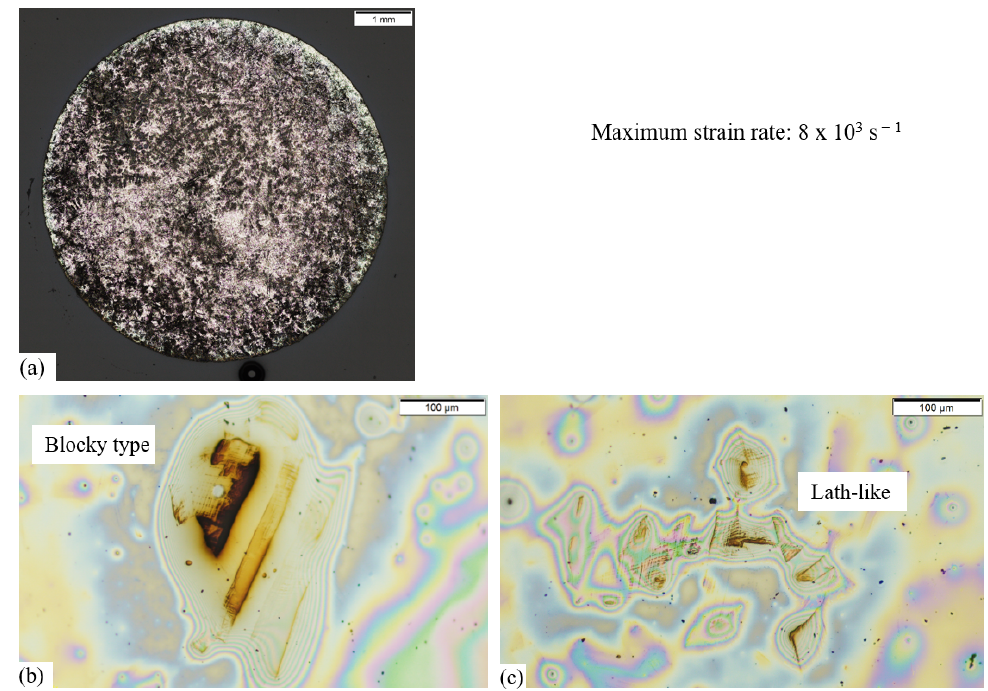
Figure 9. Microstructure analysis of the fracture area of a compression specimen tested at − 190 ◦ C: ( a ) Beraha II etching, ( b ) blocky martensite, ( c ) lath martensite.